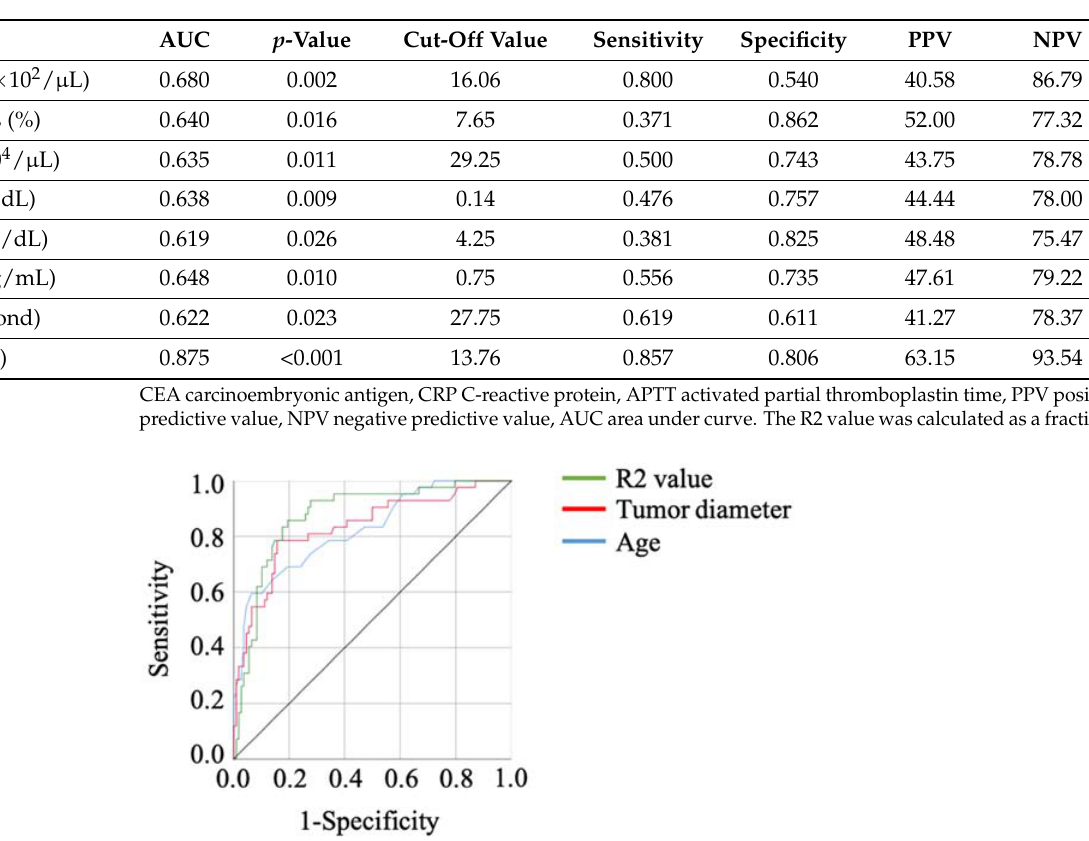
Table 4. The cut-off values discriminating EAOC from benign OE in the current cohort.